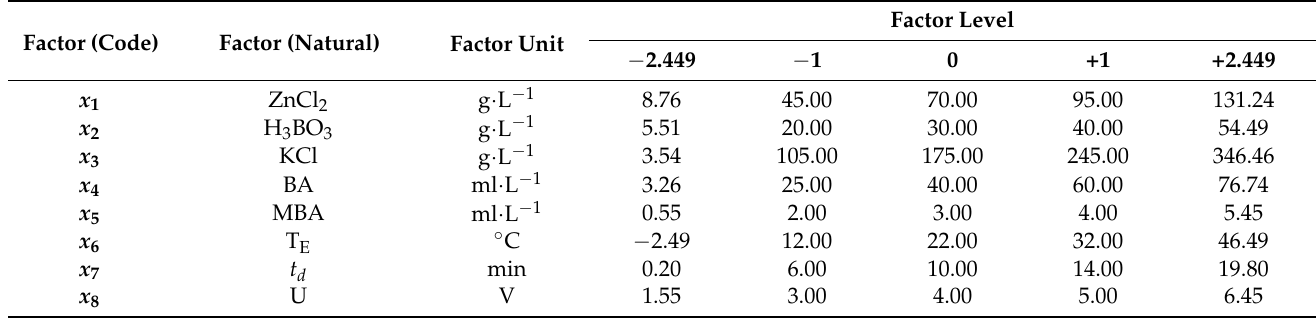
Table 1. Levels of factors (explanatory variables) used during the experiment.